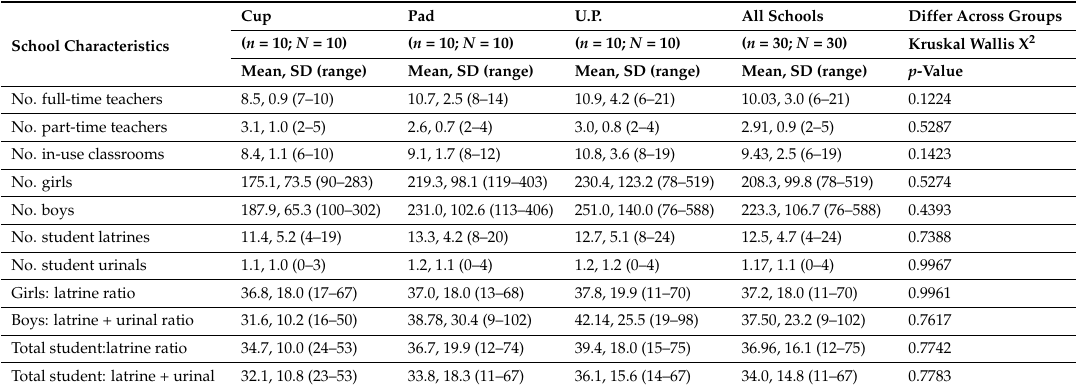
Table 1. Baseline characteristics of 30 schools in western Kenya June